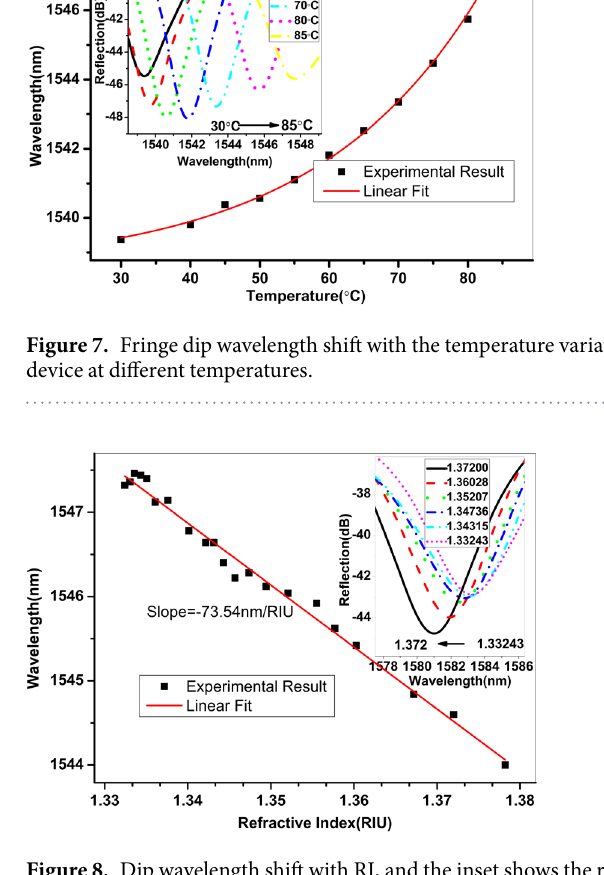
Figure 8. Dip wavelength shift with RI, and the inset shows the reflection spectra of the device at different RI